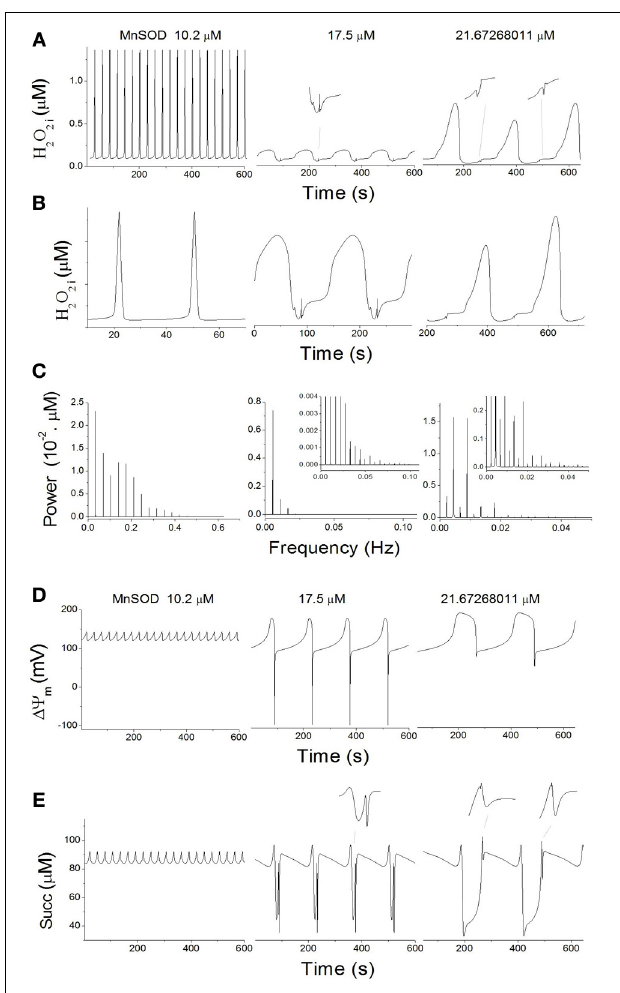
FIGURE 5 | Complex mitochondrial oscillatory dynamics. Oscillatory dynamics in H 2 O 2i (A) , (cid:2)(cid:3) m (D) , and Succ (E) at increasing concentrations of MnSOD at constant 9.7 µ M CuZnSOD and 4% Shunt (see dotted lines in Figure 3A ). (B) Depicted are the time series from panel (A) after magnification and rescaling to highlight the increase in complexity of the oscillatory waveforms. (C) Power spectral analysis of the time series from panel (A) . (D) Power spectral analysis of the time series from panel (A) , performed with a time series of 1 . 6 × 10 4 s at a constant sampling interval of